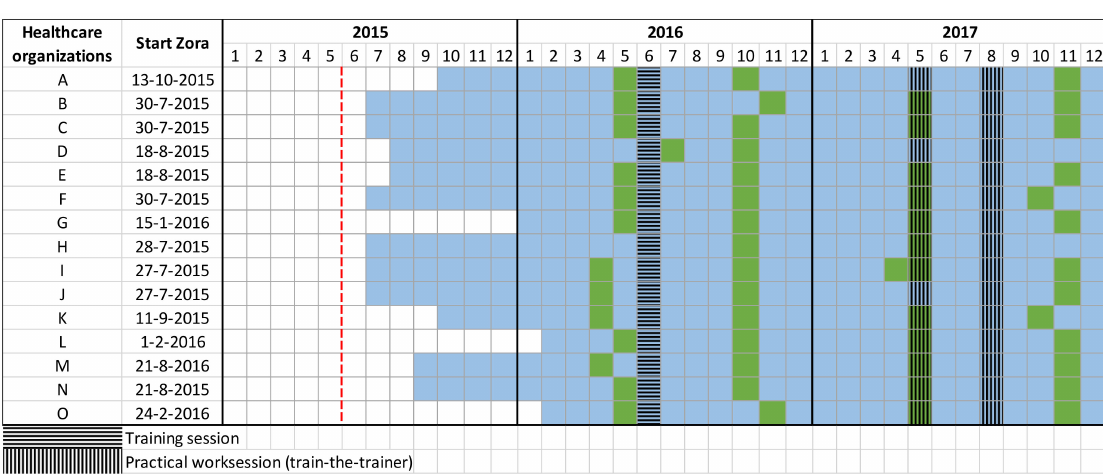
Figure 4. The monitoring and evaluation scheme of the project from the start in 2015. The first year of monitoring and evaluation was 2016, and 2017 was the second year. The field trial period of each location is indicated in blue. The measurement moments (observations and questionnaires) are illustrated in green. The start of the IVVU project is indicated by the red dotted line.